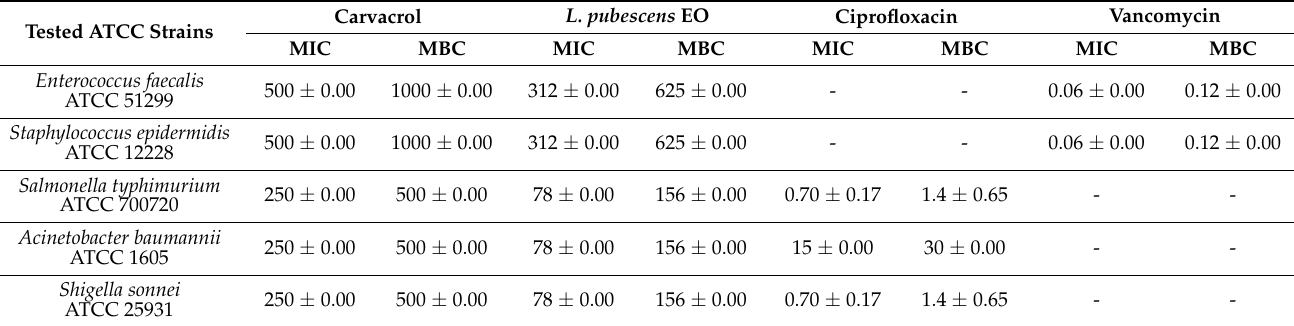
Table 4. Determination of the Minimum Inhibitory Concentration (MIC) and Minimum Bactericidal Concentration (MBC) ex- pressed in µ g/mL of carvacrol, L. pubescens EO, ciprofloxacin and vancomycin hydrochloride; data expressed as (mean ± SD) of two